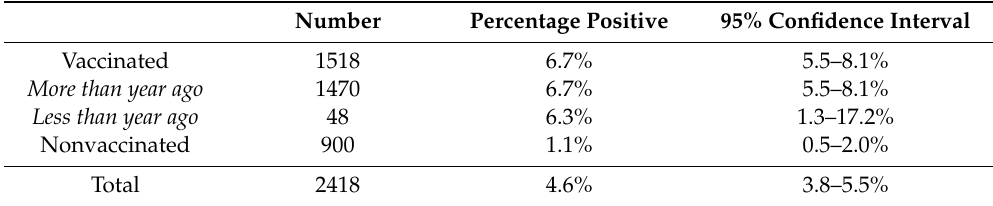
Table 1. MAP ELISA results for milk samples from 1518 vaccinated and 900 nonvaccinated Dutch dairy goats, using a cut-off of 25 S/P%.